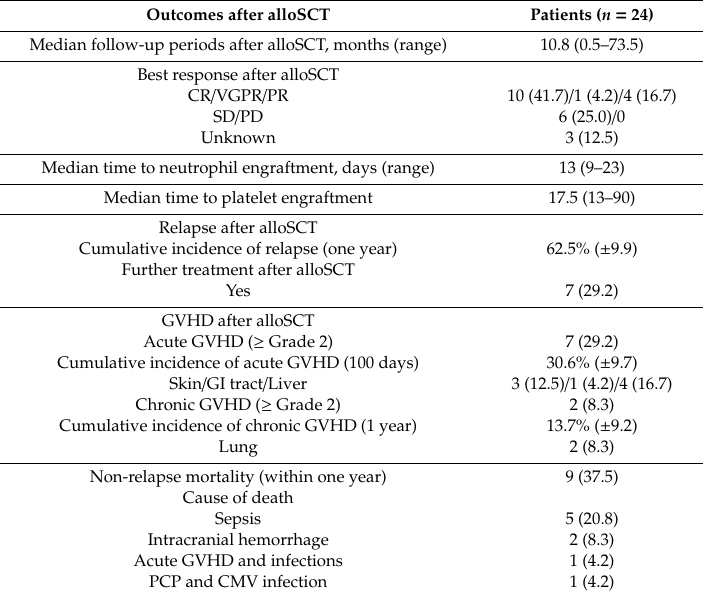
Table 2. The outcomes after